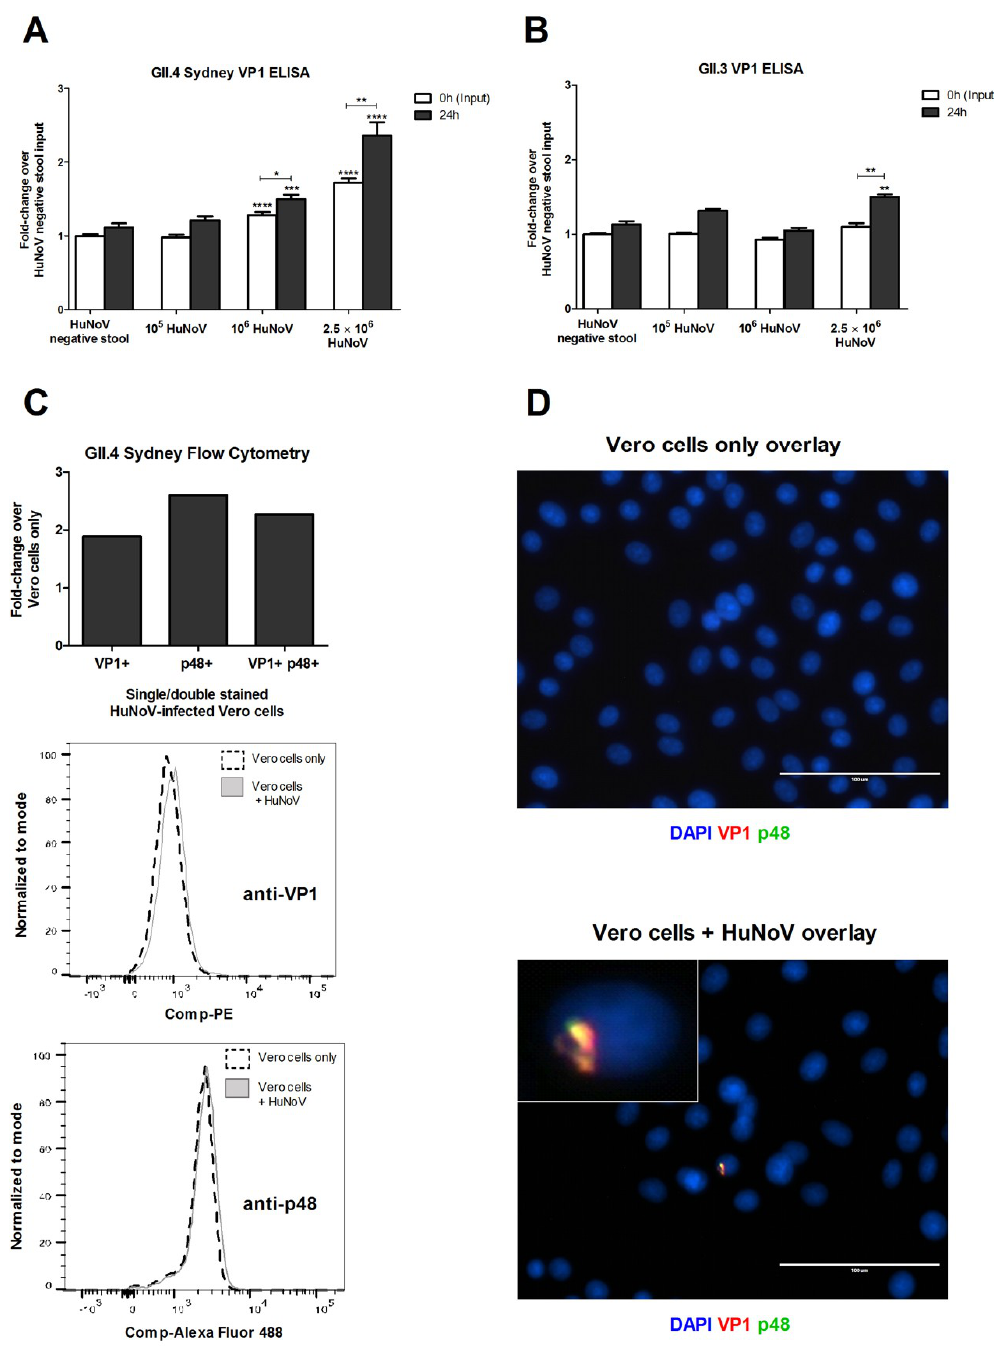
Figure 3. Detection of GII.4 Sydney ( A ) and GII.3 ( B ) HuNoV VP1 by ELISA. OD (450 nm) were measured and fold-changes normalized to HuNoV negative stool input values were graphed. Data represent n = 3 (A) or n = 1 (B) + SEM. * p < 0.05, ** p < 0.01, *** p < 0.001, and **** p < 0.0001. ( C ) Increased VP1 and p48 staining frequency in HuNoV-infected Vero cells. Detection of single-positive (VP1+ or p48+) and double-positive (VP1+ p48+) Vero cell populations following HuNoV inoculation. Histograms generated following fluorescent bead compensation with the cell counts normalized to the mode. Data represent n = 1 from 5 biological replicates. ( D ) Visualization of GII.4 Sydney VP1 and p48 proteins by immunofluorescence assay. Representative image is shown at 40 magnification from n = 3 biological replicates. VP1- or p48-associated fluorescence were not observed for secondary antibody only (2 º) treated cells. The inset shows a HuNoV-infected Vero cell.